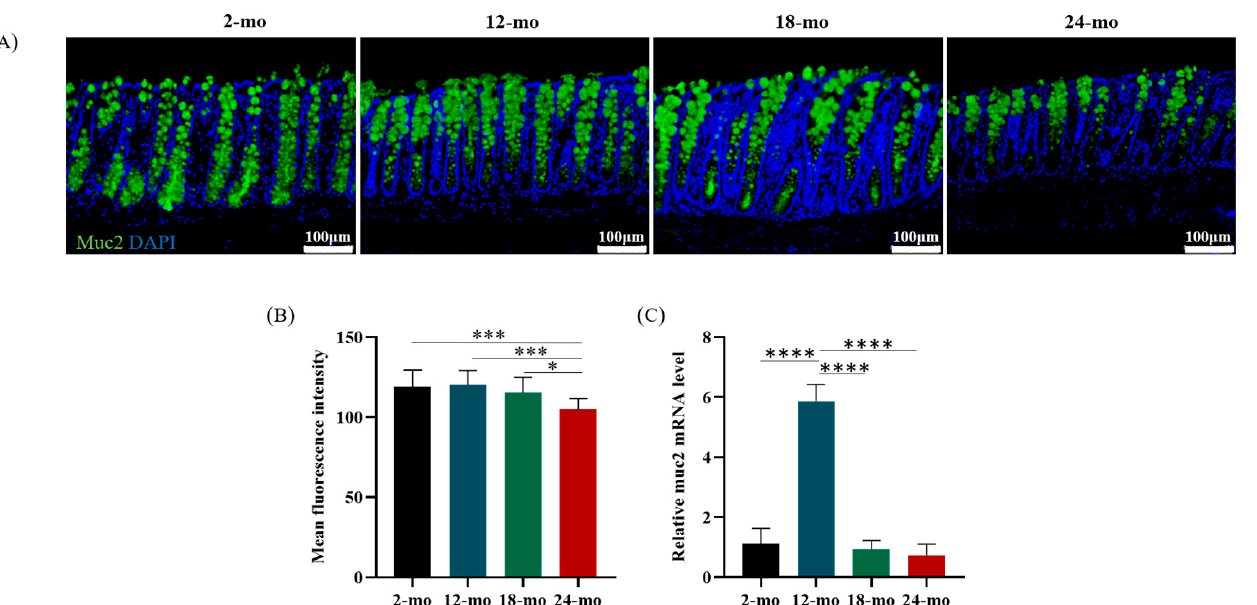
Figure 3. Physiological characteristics of colonic mucus in aging mice. The pH ( A ), mucus weight per unit length ( B ), water content ( C ), and dry ma tt er content ( D ) of colonic mucus in aging mice were determined. Data were presented as mean ± SD. Data were statistically analyzed using one- way ANOVA with Tukey’s post hoc test. Asterisk indicates signi fi cant di ff erence, * p < 0.05, ** p < 0.01, *** p < 0.001, **** p < 0.0001, n = 3 per group.